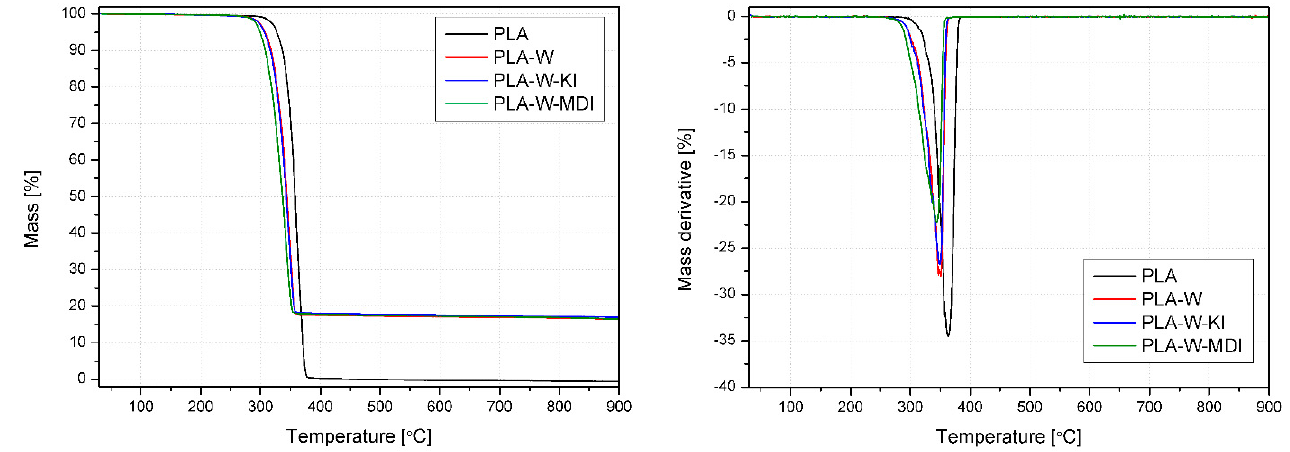
Figure 14. TG and dTG curves of PLA and PLA-W composites. Table 3. Thermal parameters obtained for PLA and PLA-based composites obtained from TGA.